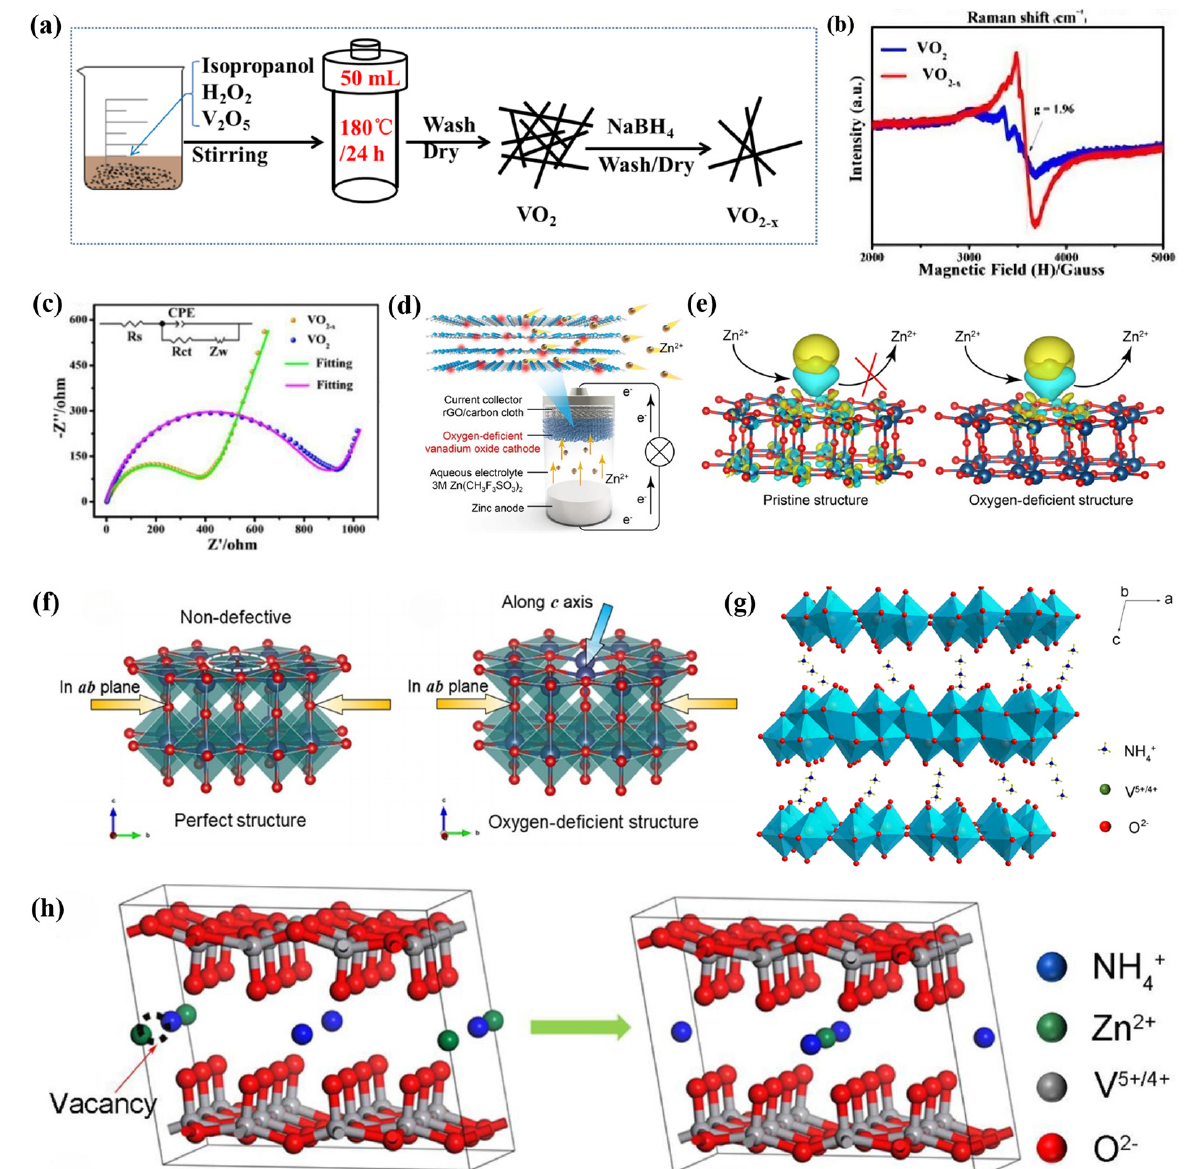
Figure 4. ( a ) Preparation flow chart of VO 2 and VO 2 − x (Ref. [53]). ( b ) Electron paramagnetic reso- nance (EPR) spectra of VO 2 and VO 2 − x (Ref. [53]). ( c ) Nyquist diagram of VO 2 and VO 2 − x (Ref. [53]). ( d ) Structure and discharge process of Zn/O d − VO battery (Ref. [54]). ( e ) Zn 2+ acceptance/release model of V 6 O 13 before and after modification (Ref. [54]). ( f ) The charge distribution and corre- sponding structure of p − VO and O d − VO (Ref. [54]). ( g ) Crystal structure diagram of NH 4 V 4 O 10 (Ref. [55]). ( h ) Diffusion diagram of Zn 2+ in ZNV with NH 4+ interlayer vacancy (Ref. [55]).